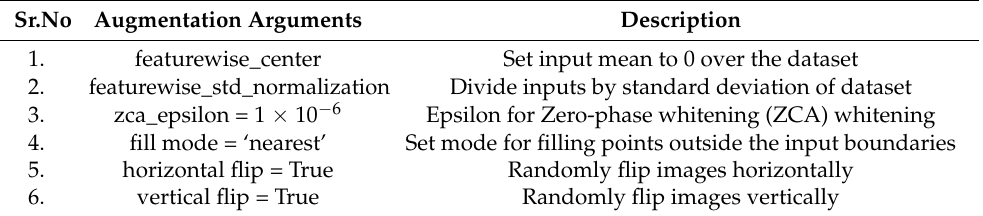
Table 4. List of selected real-time augmentation with arguments and their description.